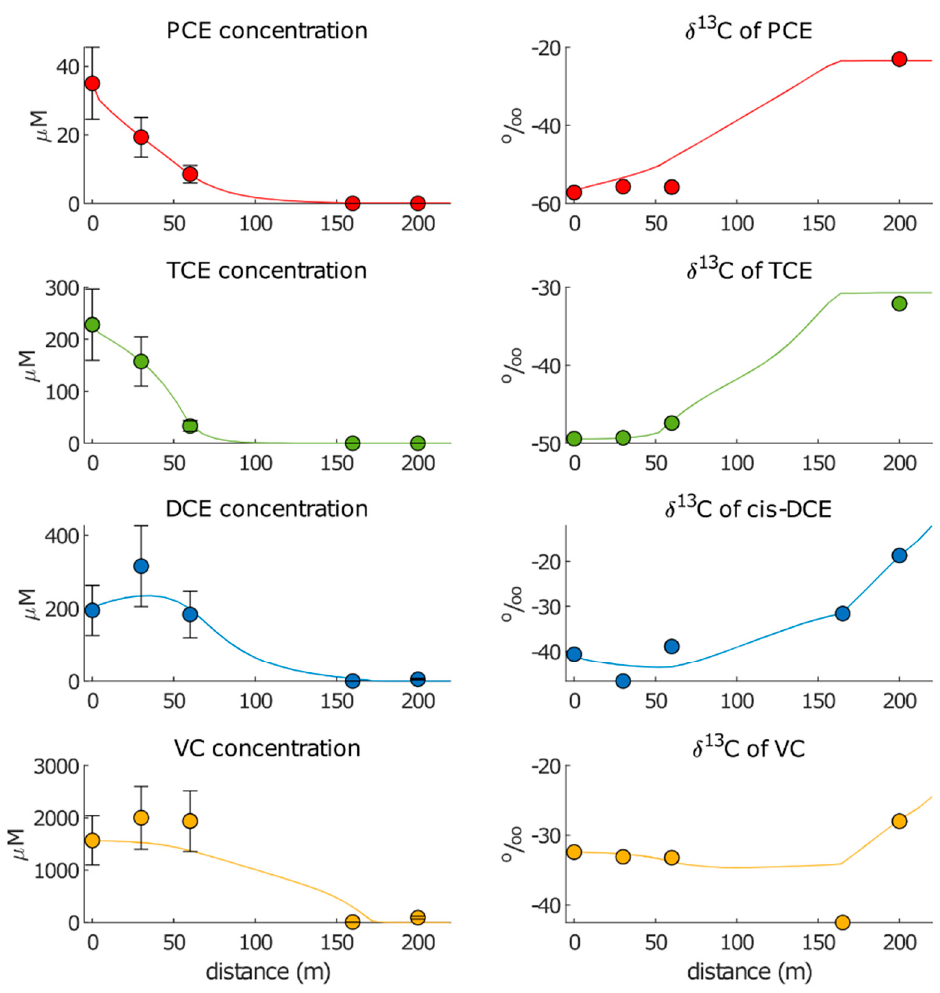
Figure 5. Simulated (lines) and observed (dots) chloroethenes concentrations and isotopic compositions using the first calibration (“Approach 1”).